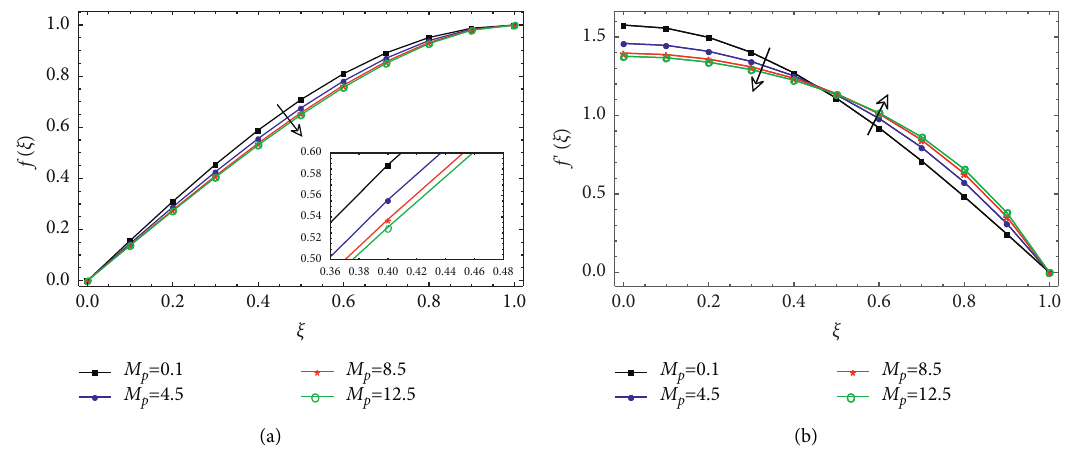
Figure 8: Effect of M p on the velocity profile keeping component of velocity.